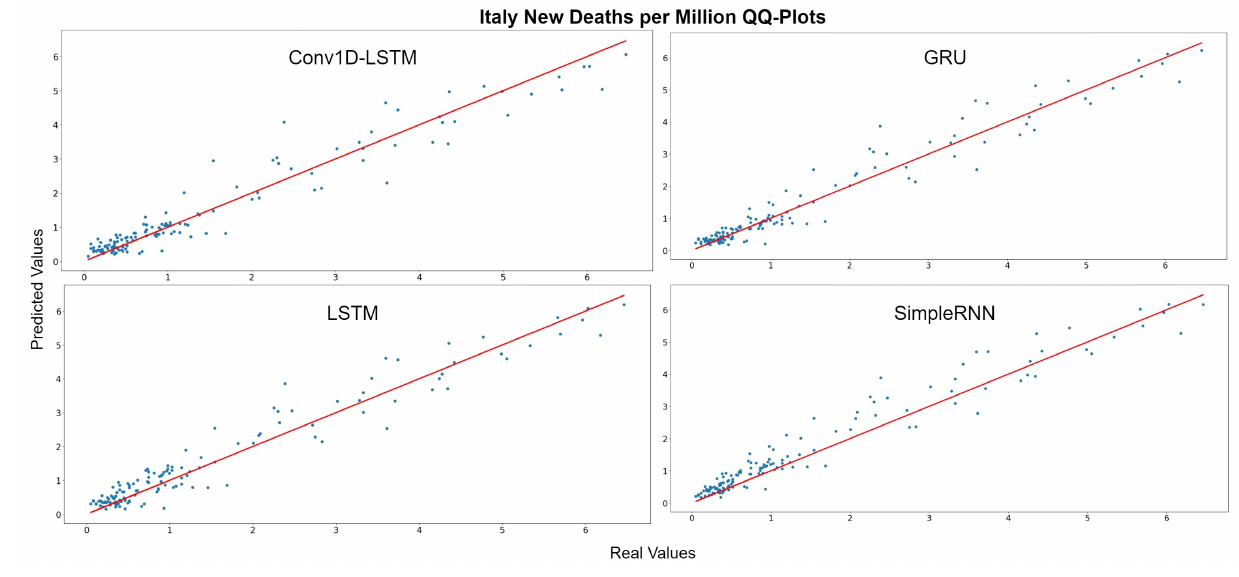
Figure 9. Italy’s new deaths per million QQ-Plot for each method.